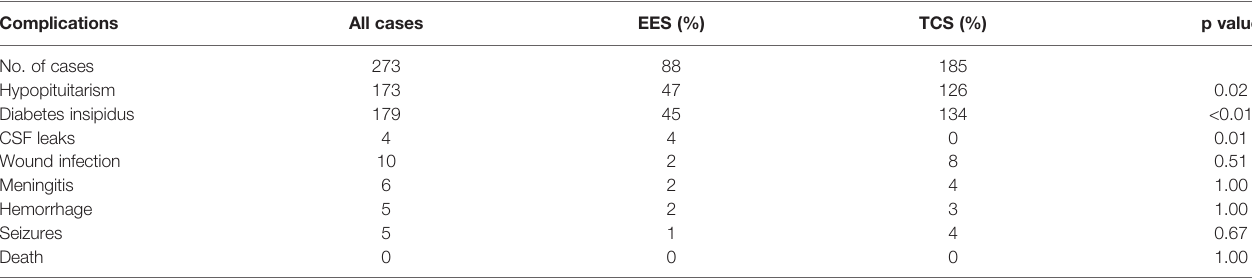
TABLE 3 | Main postoperative and perioperative complications.